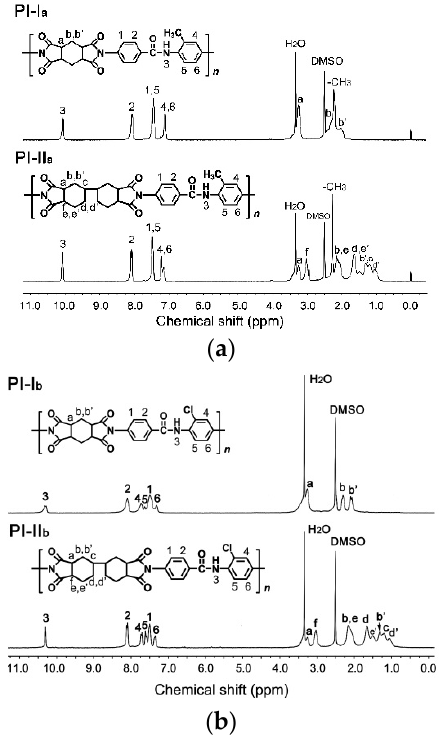
Figure 4. 1 H-NMR spectra of PI resins. ( a ) MeDABA-PIs; ( b ) ClDABA-PIs.